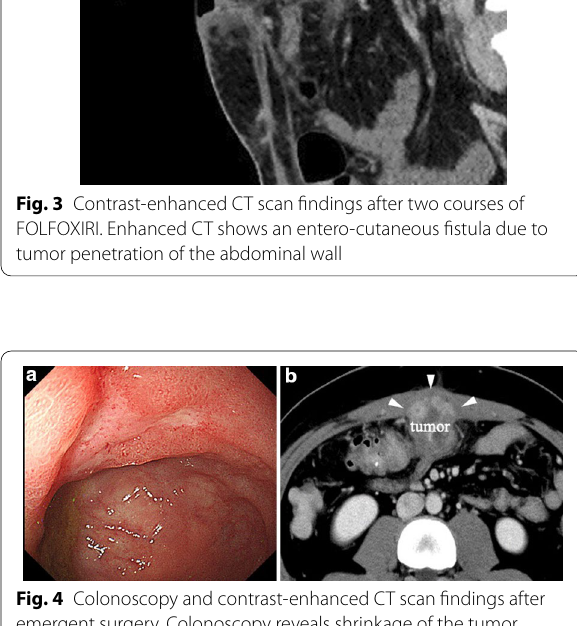
16 cm of fascia and 6 9 cm of × ×